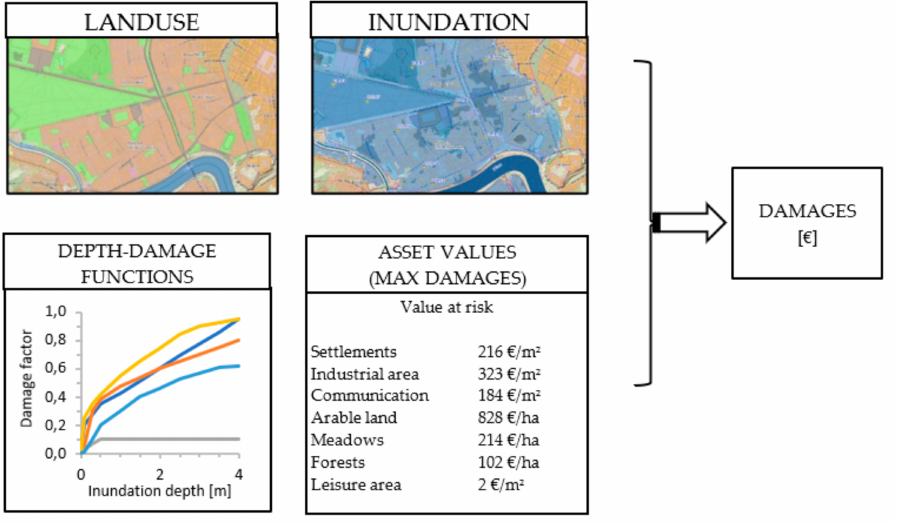
Figure 1. The methodology of flood loss estimation (based on